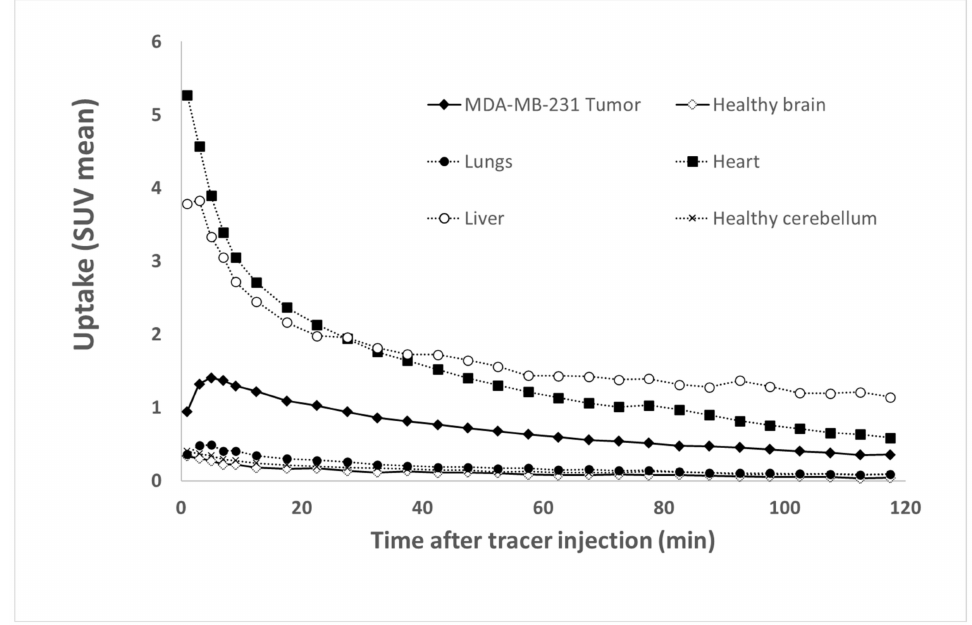
Figure 9. Tissue Time Activity Curves (TTACs) showing the fixation profiles of [ 68 Ga]Ga-NODAGA- K(Cy5)DKPPR for tumors and various